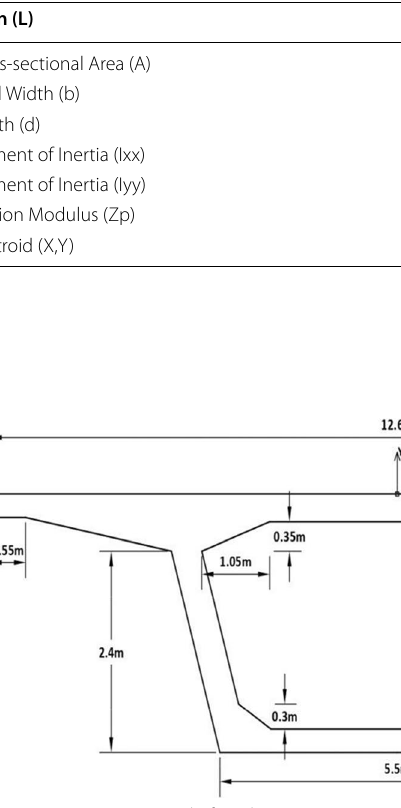
Fig. 4 Cross-section Detail of Deck